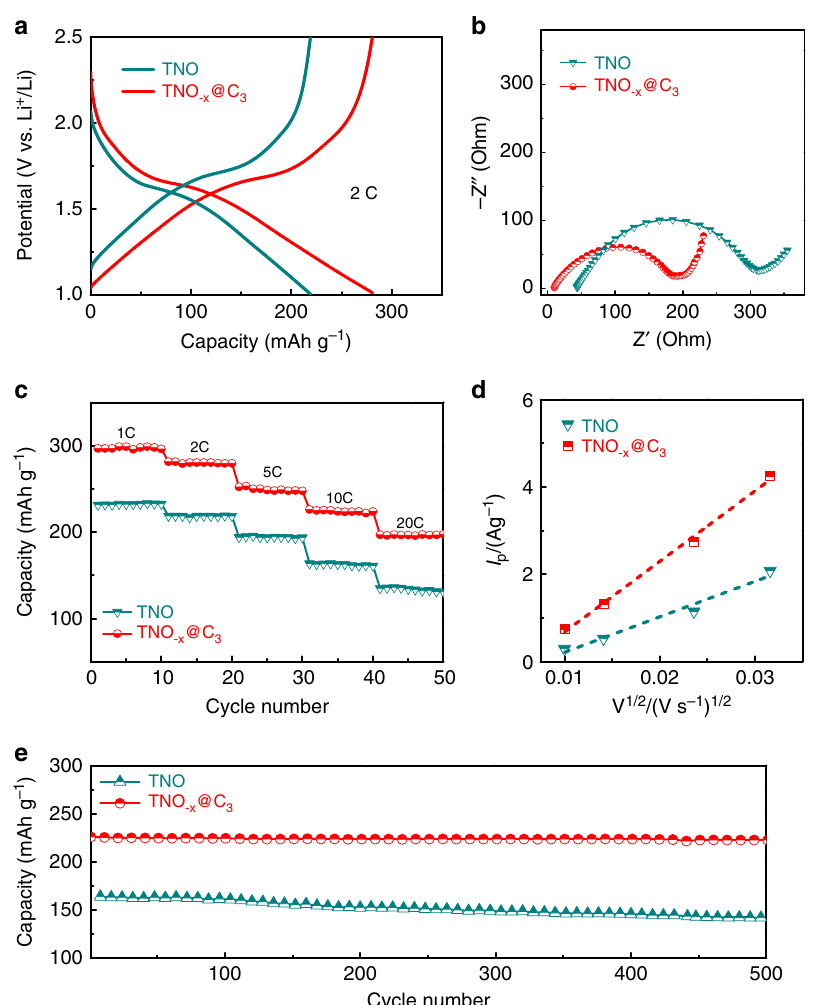
Fig. 5 Electrochemical characterization of TNO and TNO − x @C 3 electrodes. a Discharge/charge pro fi les. b Nyquist plots at the fully discharge state at the fi rst cycle. c Rate capability. d Peak current I 1/2 . e Cycling stability at 10 p as a function of square root of scan rate V